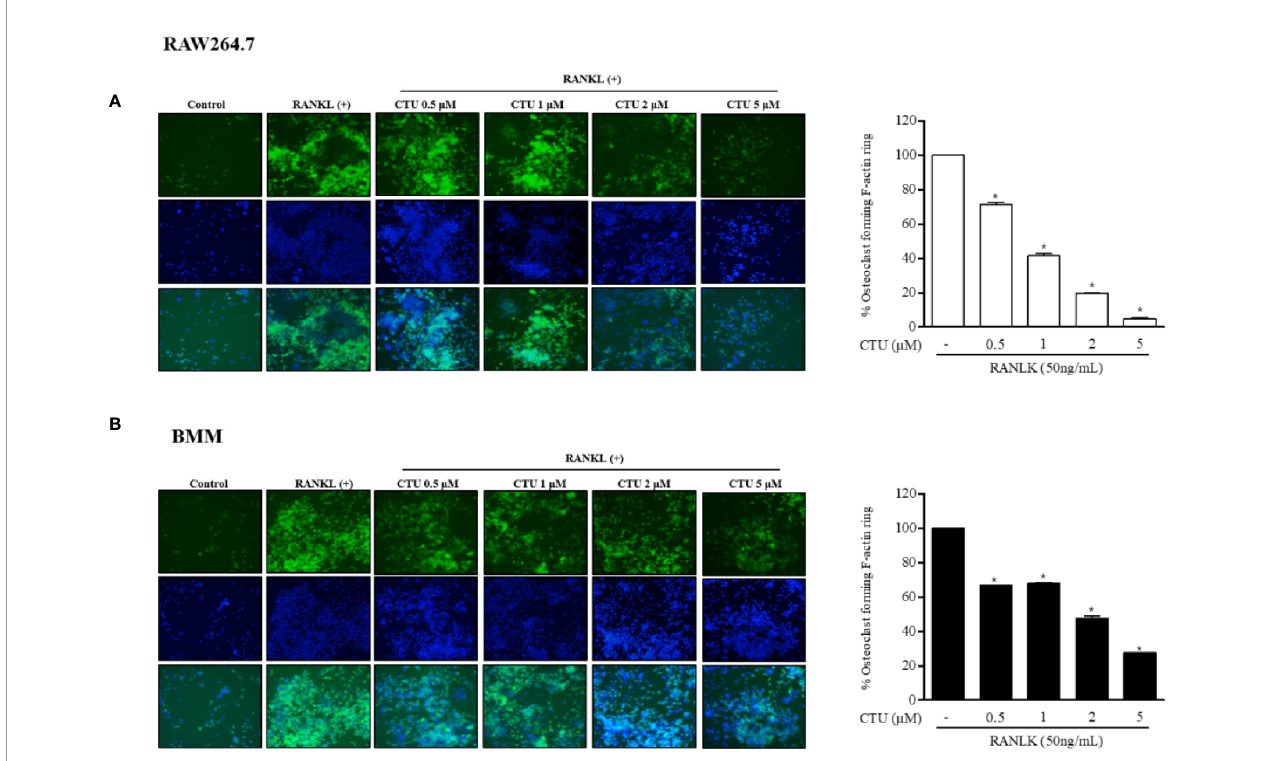
FIGURE 3 | The effect of CTU on osteoclast-actin ring structures in RANKL-induced RAW 264.7 (A) and BMM (B) cells. RAW 264.7 cells were treated with different concentrations of CTU in the presence of RANKL. After fi xation and incubation with Alexa Fluor 488-conjugated phalloidin stained with DAPI, cells were visualized under a fl uorescence microscope. Quantitative analysis shows percentage of osteoclasts forming F-actin rings. * p < 0.05 compared with the only RANKL-treated